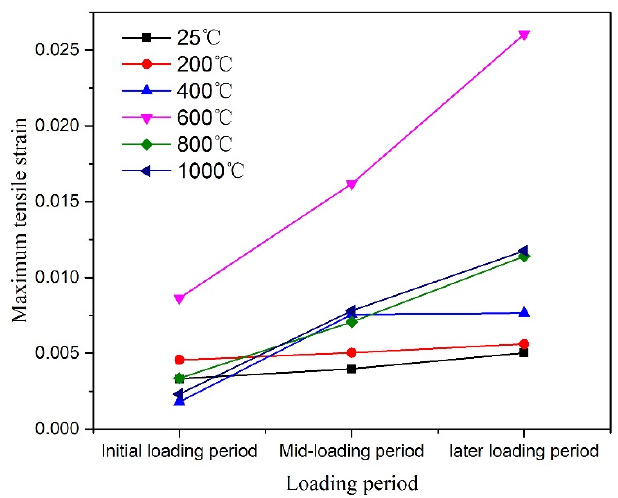
Figure 15. Maximum tensile strain during impact